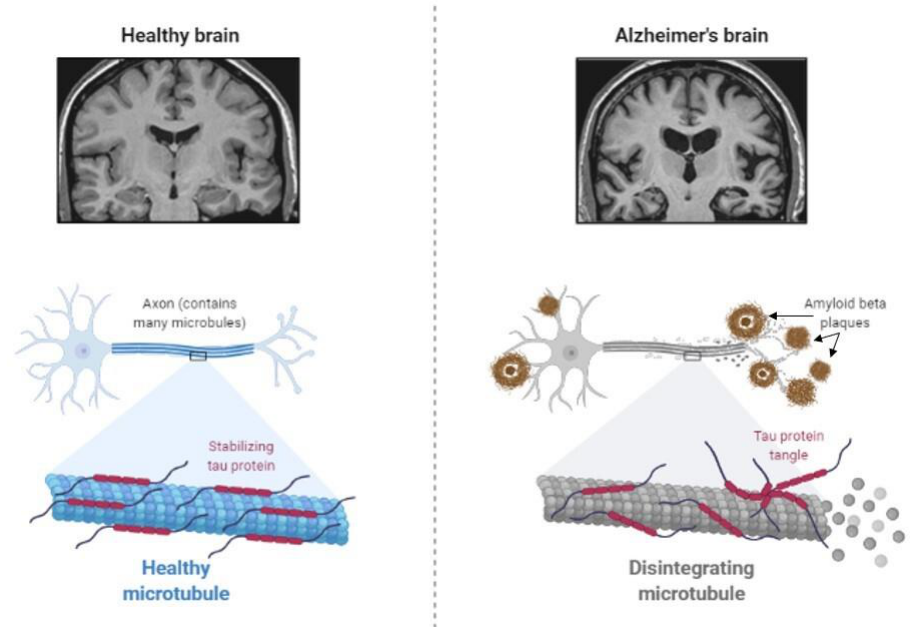
Figure 2. Abnormal protein processing occurs in the brain of patients with Alzheimer’s disease, which leads to the disintegration of microtubules and formation of tau aggregates and amyloid- β plaques, causing morphological pathologies, several cognitive impairments, and behavioral changes (Created by BioRender.com, accessed on 23 August 2021).